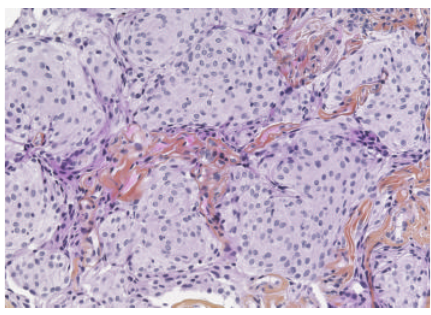
Figure 2: Haematoxylin and eosin staining showing an infiltrative growth pattern with whorled appearance.